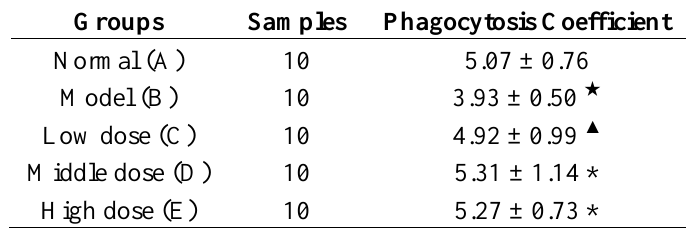
Table 6. Effect of Fuzhuan brick-tea extract on mononuclear macrophage immune function ( x ± s).